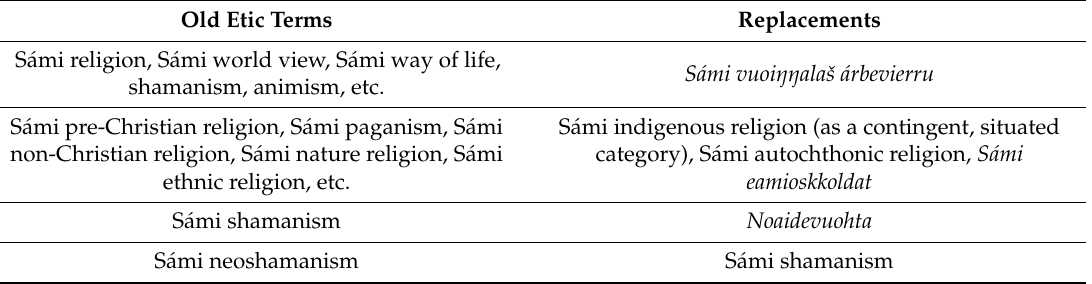
Table 1. Suggestions for analytical